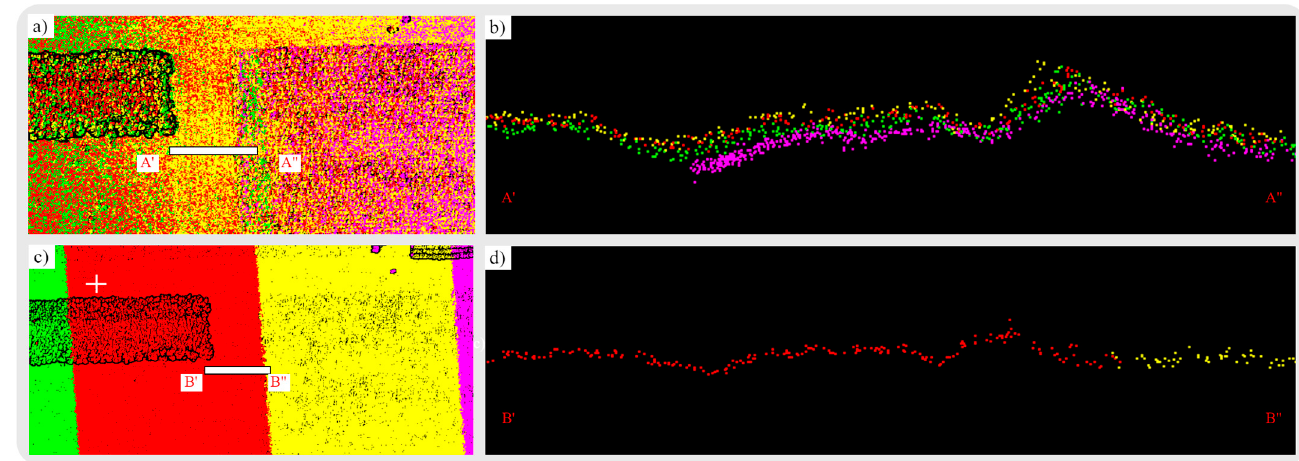
Figure 3. Strip adjustment of DJI L1 sensor: ( a ) Offset and overlapping UAS-LiDAR point clouds strips, ( b ) transect A’A” before strip adjustment. ( c ) Strip adjusted point clouds, and ( d ) transect B’B” after strip adjustment. Three-dimensional transects ( b – d ) are of the same extent (horizontal) for visualization purposes with no vertical scale.